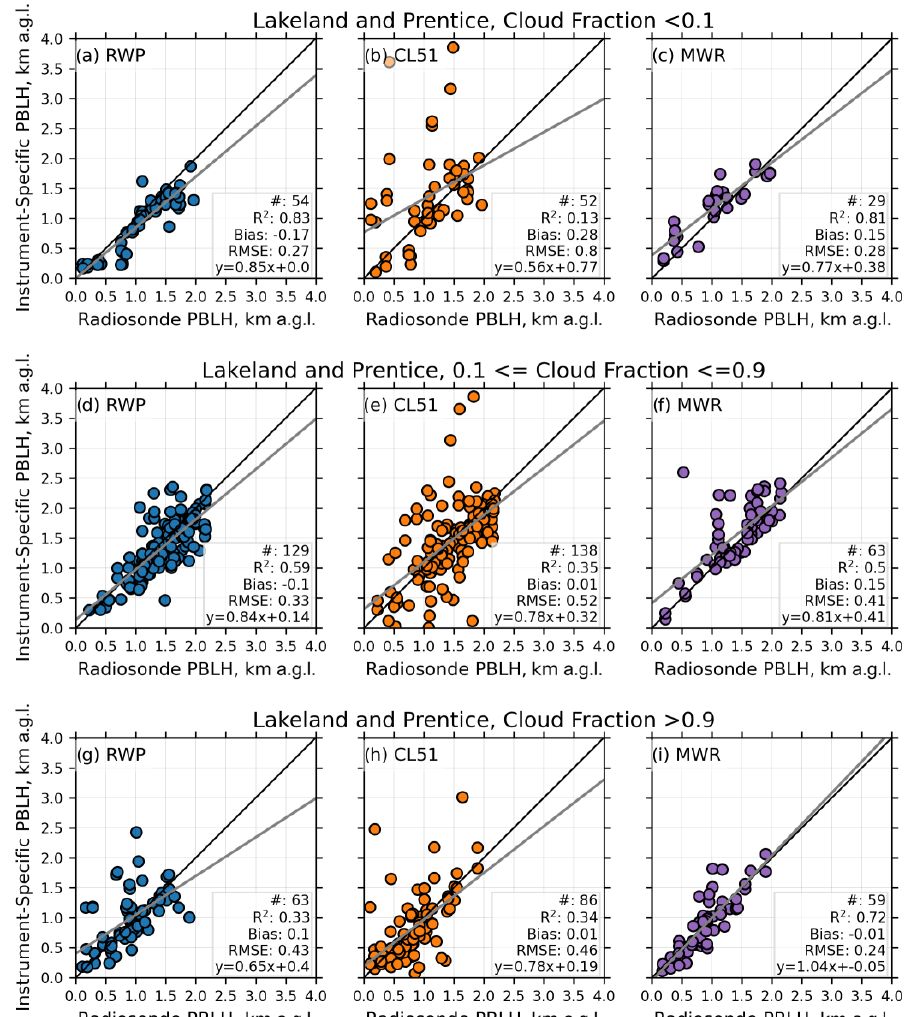
Figure 11. The same as in Fig. 9 at the Lakeland and Prentice sites but divided for the times with RadSys cloud fraction values less than 0.1 (a–c) , for the times with RadSys cloud fraction values between 0.1 and 0.9 (d–f) , and for the times with RadSys cloud fraction values larger than 0.9 (g–i) . Black lines represent the 1-to-1 line, and grey lines represent the best-fit